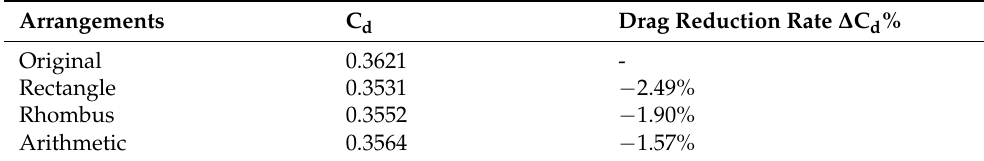
Table 4. CFD simulation results of three arrangements.